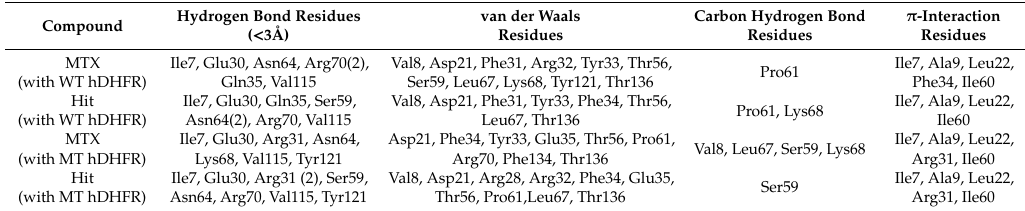
Table 5. Molecular interactions between the ligands (MTX and hit compound) and the active site residues of WT and MT